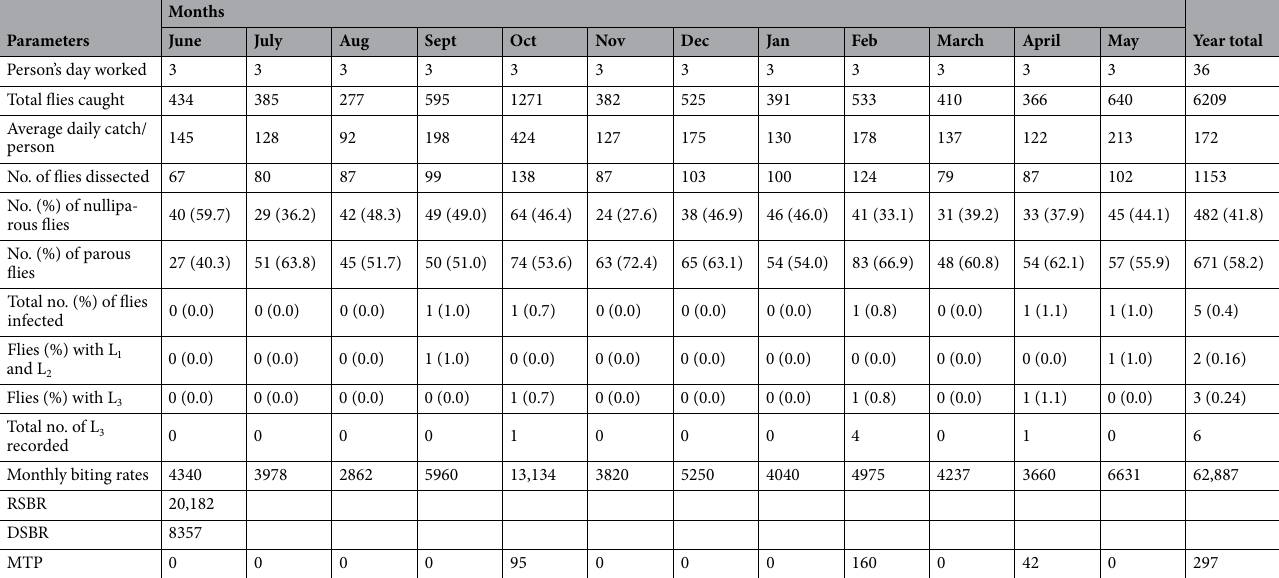
Table 2. Population density and transmission indices of S. damnosum at Kwa falls (Aningeje). [RSBR = Rainy season biting rate (May–October), DSBR = Dry season biting rate